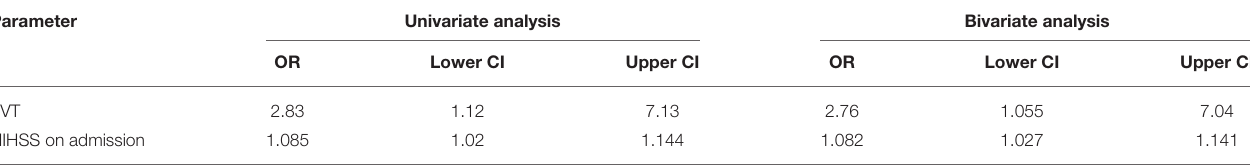
TABLE 4 | Univariate and bivariate analysis for the primary endpoint ENI (delta NIHSS ≥ 4 or post-NIHSS = 0.